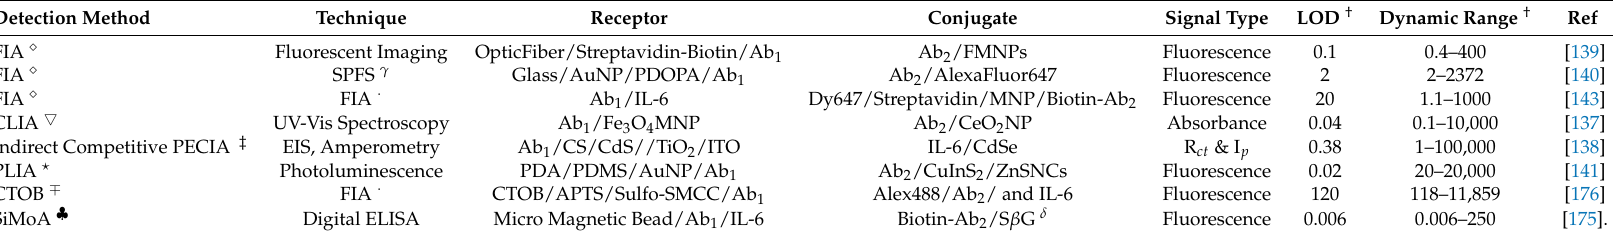
Table 3. Properties of optical biosensors designed for IL-6